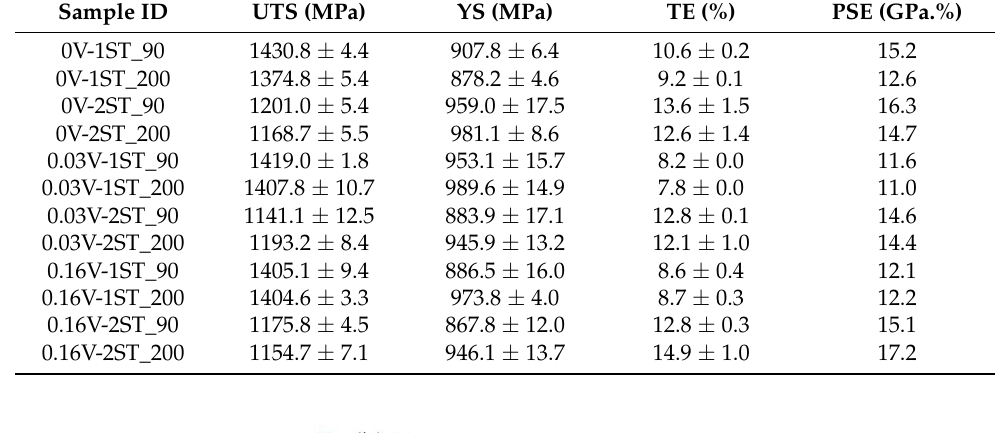
Table 2. Mechanical properties of the three experimental steels subjected to the Q&P treatment.